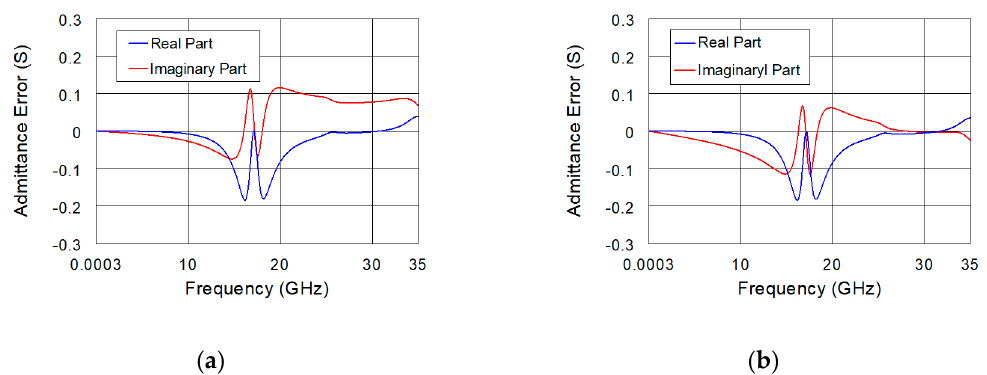
Figure 12. Difference between FEM and equivalent-circuit simulations of the real (blue lines) and imaginary parts (red lines) of the admittance from 0.3 MHz to 35 GHz for the IDC sensor loaded with a lossless MUT having a real part of the relative permittivity of 70: ( a ) equivalent-circuit simulations based on the local model and ( b ) equivalent-circuit simulations based on the modified broadband model.